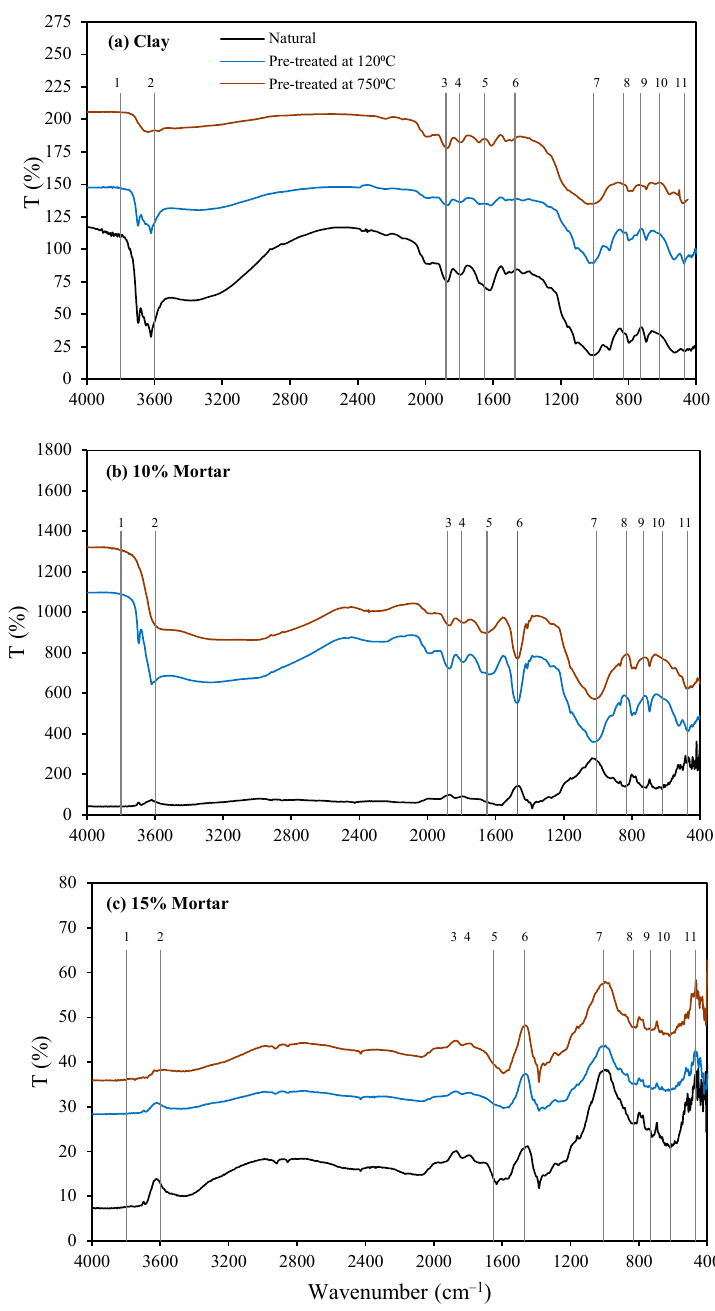
Figure 5. FTIR spectra: ( a ) clay, ( b ) 10% mortar, and ( c ) 15% mortar. The peaks in the region of 3800–3600 cm − 1 present in the untreated clay and clay treated at 120 °C are attributed to O–H stretching and bending vibrations of the hydroxyl groups of kaolinite and illite [53,64,65]. These disappear in the spectra of the clay pre- treated at 750 °C, which is consistent with the conversion of kaolinite and illite as observed in the XRD data. The peaks observed between 1650 and 1600 cm − 1 in the clays are associ- ated with the H–O–H vibrations of absorbed water. These decrease in intensity in both